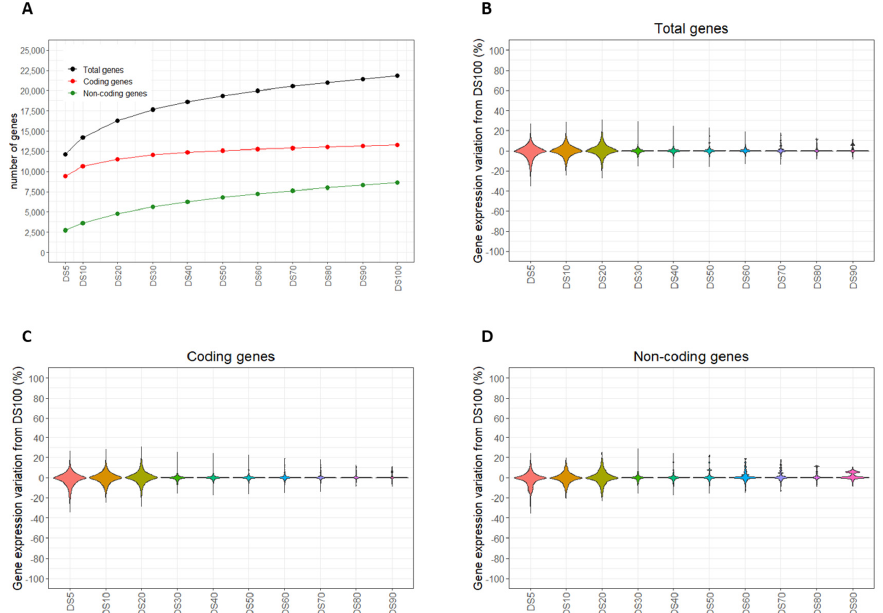
Figure 4. Sequencing results of total, coding, and non-coding genes as a function of the read depth. ( A ) Number of total, coding, and non-coding genes in each dataset (black, red, and green lines, respectively). Distributions of gene expression variation of ( B ) total, ( C ) coding, and ( D ) non-coding genes in each subset.